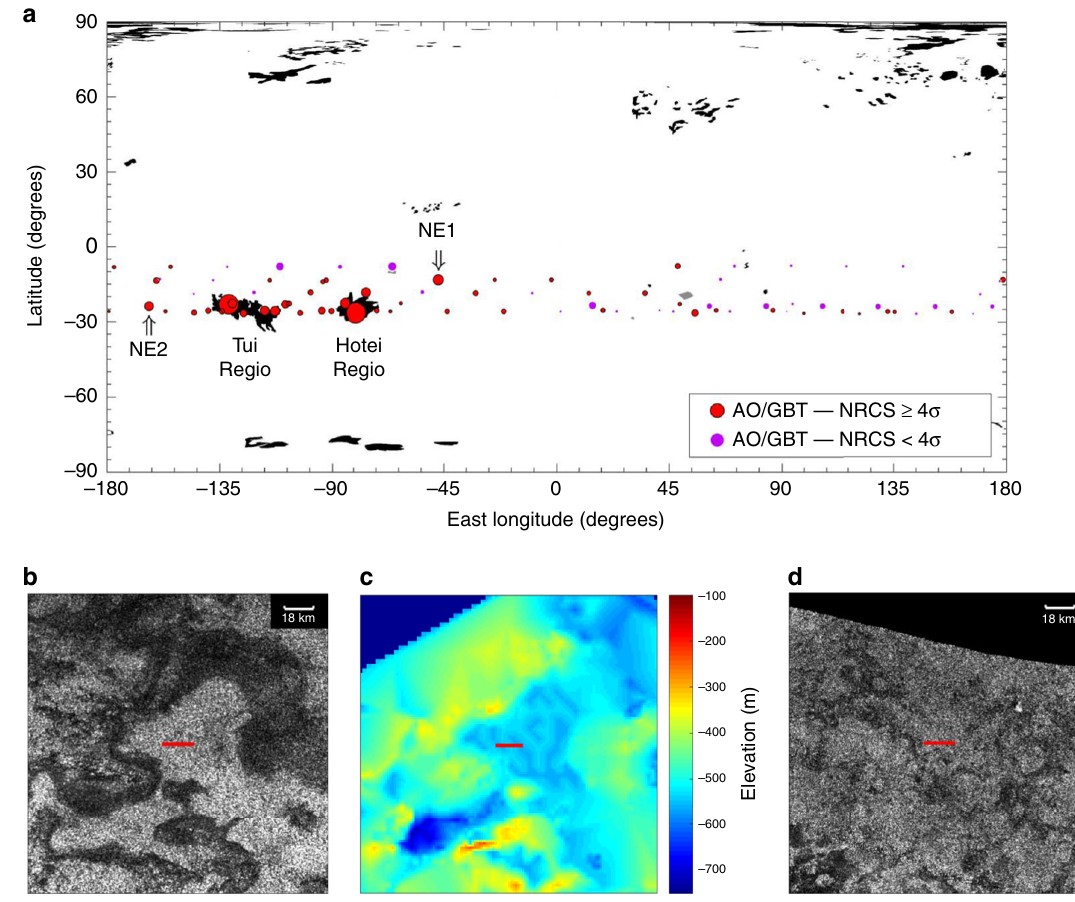
Fig. 4 Hotei and Tui Regiones. a Black areas are Titan ’ s 5- μ m-bright regions as mapped in MacKenzie et al. 24 . Hotei and Tui Regiones are the 5- μ m-bright regions at ≈ 80°W, 25°S and ≈ 120°W, 25°S. AO/GBT observations are plotted as in Fig. 2. Hotei and Tui Regiones are the main source of the AO/GBT anomalously specular re fl ections. Two noteworthy exceptions to the strong correlation of anomalously specular AO/GBT observations to Hotei/Tui are labeled NE1 and NE2 and discussed in the Discussion section. b The 18-km subradar track (red line) of the highest maximum-NRCS (and most specular in Black et al. 2 ) AO/GBT observation, located in Hotei Regio (largest red dot in Hotei Regio in a ). c The stereo topography of the same area 37 . The AO/GBT re fl ection is from a bright area that is morphologically similar to paleolakes 25 ( b ) and is topographically low ( c ). d The 18-km subradar track (red line) of the second highest maximum-NRCS (and second most specular in Black et al. 2 ) AO/GBT observation, located in Tui Regio (largest red dot in Tui Regio in a ). The AO/GBT re fl ection is again from a bright area that is morphologically similar to the comparably specular location in Hotei Regio and paleolakes. Stereo topography does not cover this